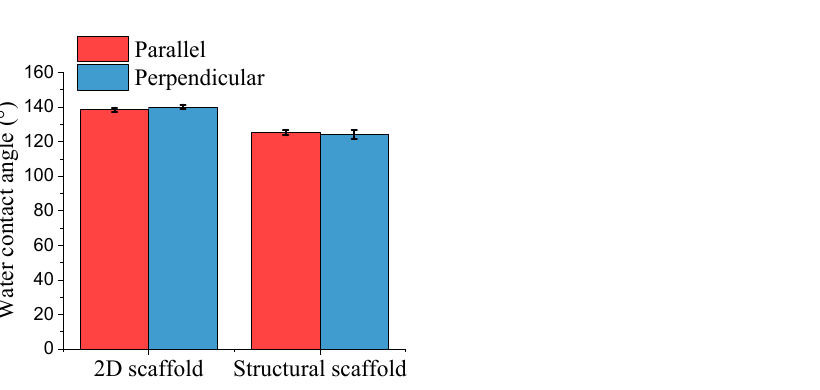
Figure 5. Viability of adult human dermal fibroblast (HDF) cells cultured for 8 days on different morphologies of PCL scaffolds.